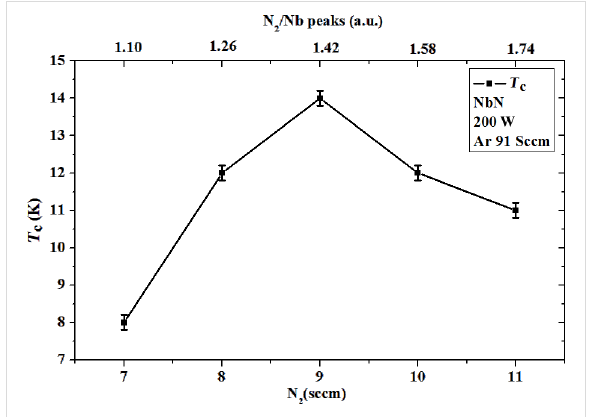
Figure 4: Critical temperature T c of NbN as a function of the N 2 flux and of the of N 2 /Nb peak ratio. In the inset the deposition parameters are